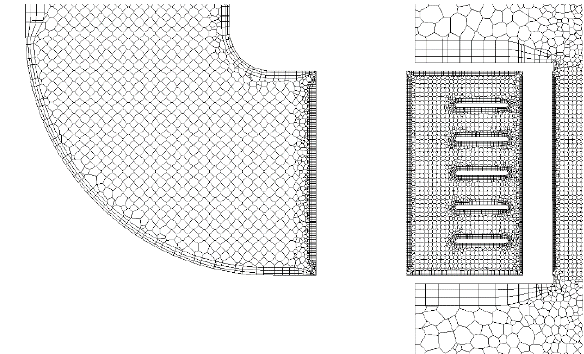
Fig. 4. Detail of the mesh used for RANS simulations [10]